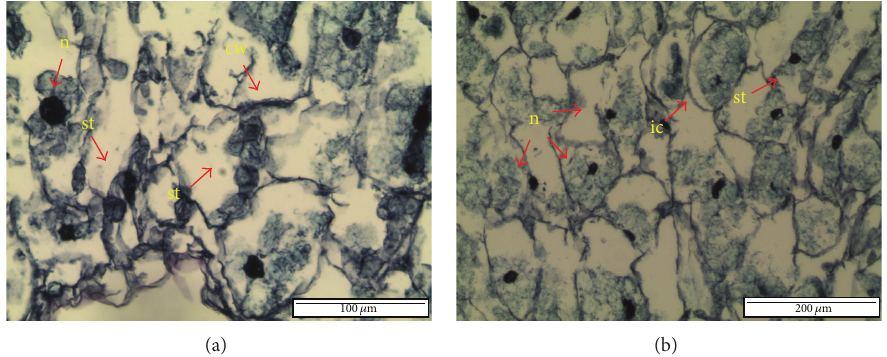
Figure 2: Cross-section of noncryopreserved PLB. (a) Original PLB. Nucleus was deeply stained, cell walls were thickening, and starch grains were dense. (b) Regenerated portion. Cells were intact with dense nuclei, and some starch was observed (ic: intact cell; cw: cell wall; n: nucleus; st: starch).